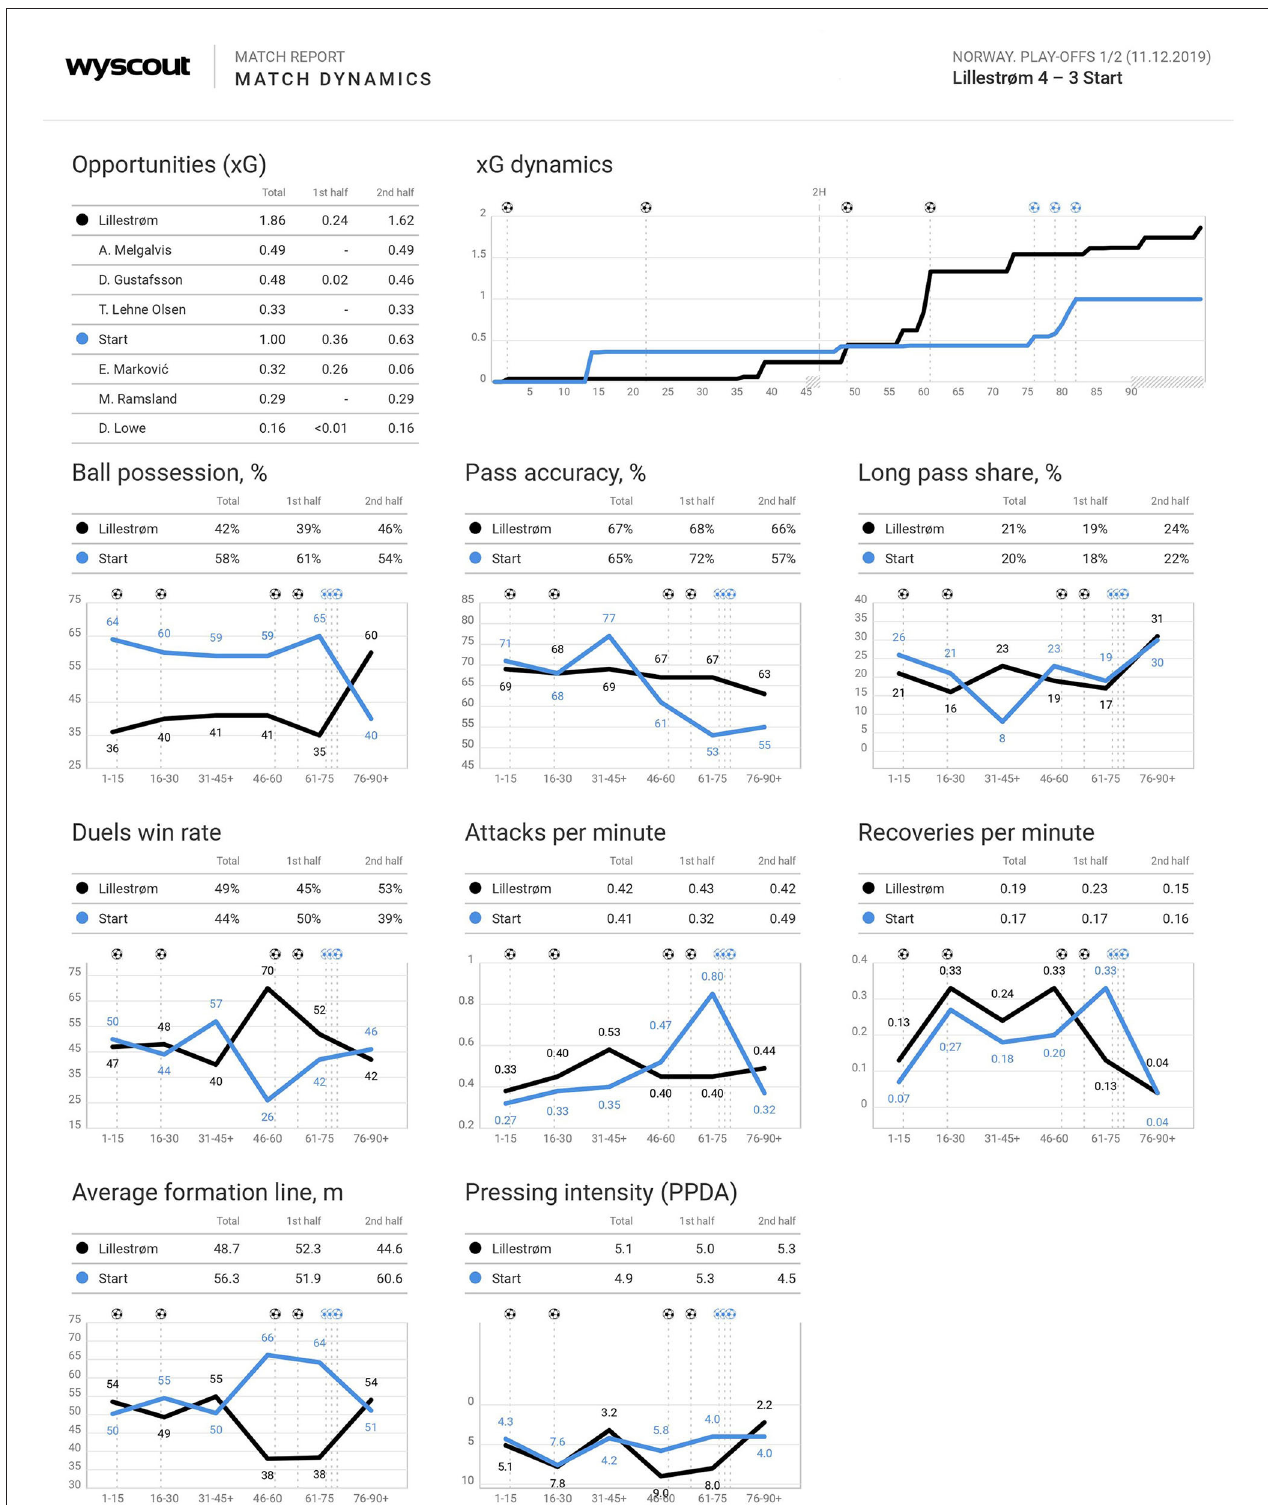
FIGURE 2 | Excerpt of the match report received from Wyscout. Published with permission from Wyscout.